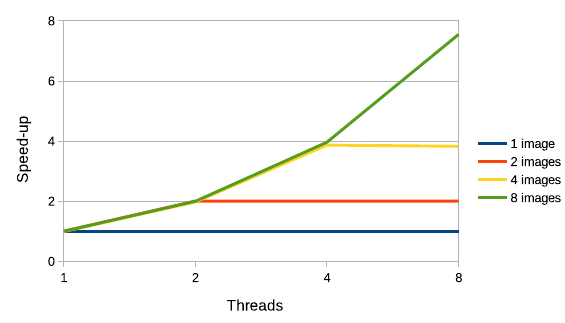
Figure 7: Speed-up in the TILE-Gx36 for application-level par-